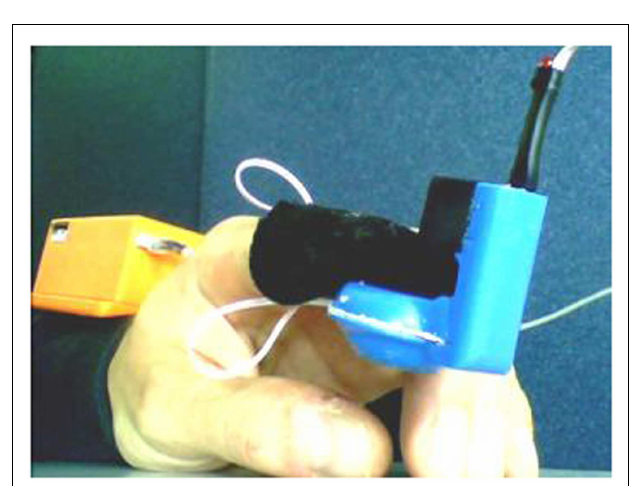
FIGURE 7 |Actuator’s performance .Voltage-induced free stroke of the top passive membrane (A) . Blocking force versus voltage (B) . Error bars represent a 95% confidence interval. Fitting lines are used as a guide for the eye.